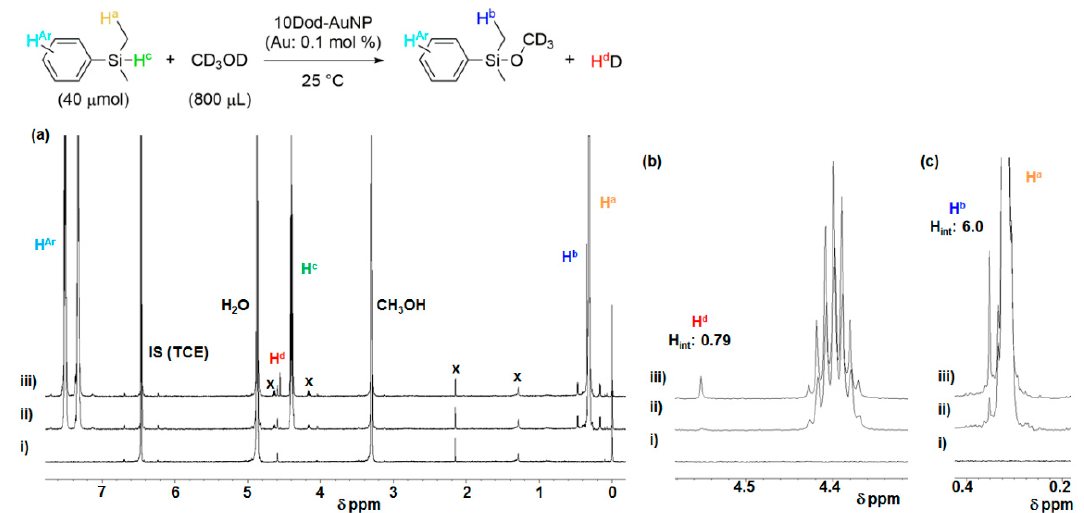
Figure 5. ( a ) Full scale and ( b ), ( c ) magnified 1 H NMR spectra (400 MHz) of the silane alcoholysis reaction solution in CD 3 OD. (i) Before the addition of DMPS, (ii) 15 min and (iii) 90 min after the addition of DMPS.